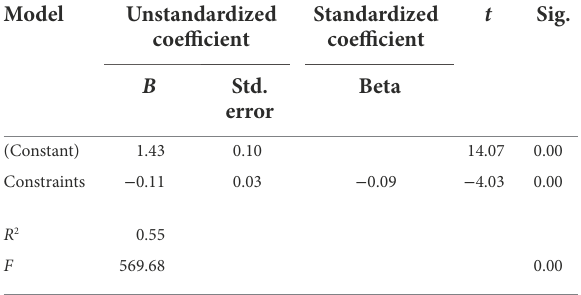
TABLE 5 Logistic regression analysis between constraints and